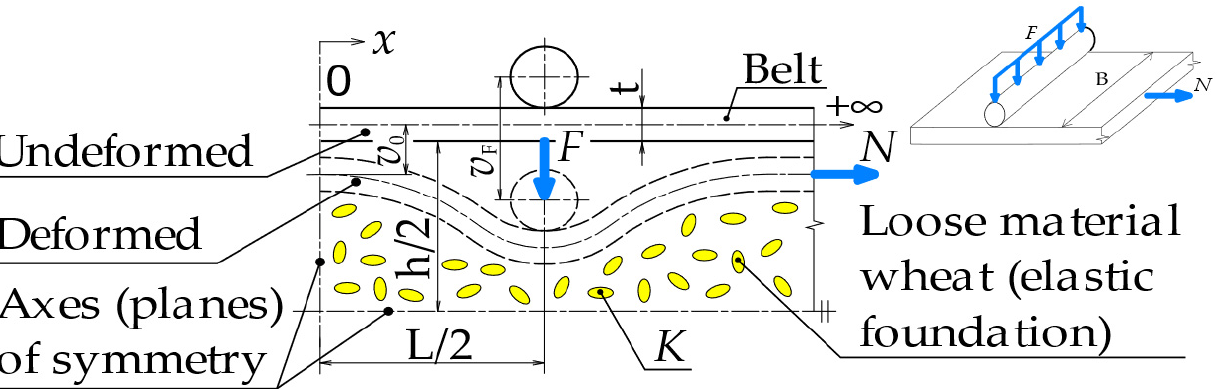
Figure 7. Belt of conveyor as a beam on an elastic foundation using symmetry.